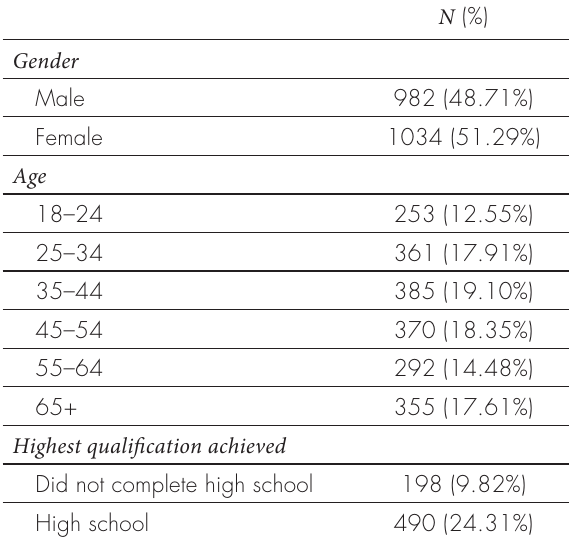
Table I. Demographic characteristics of sample ( n =